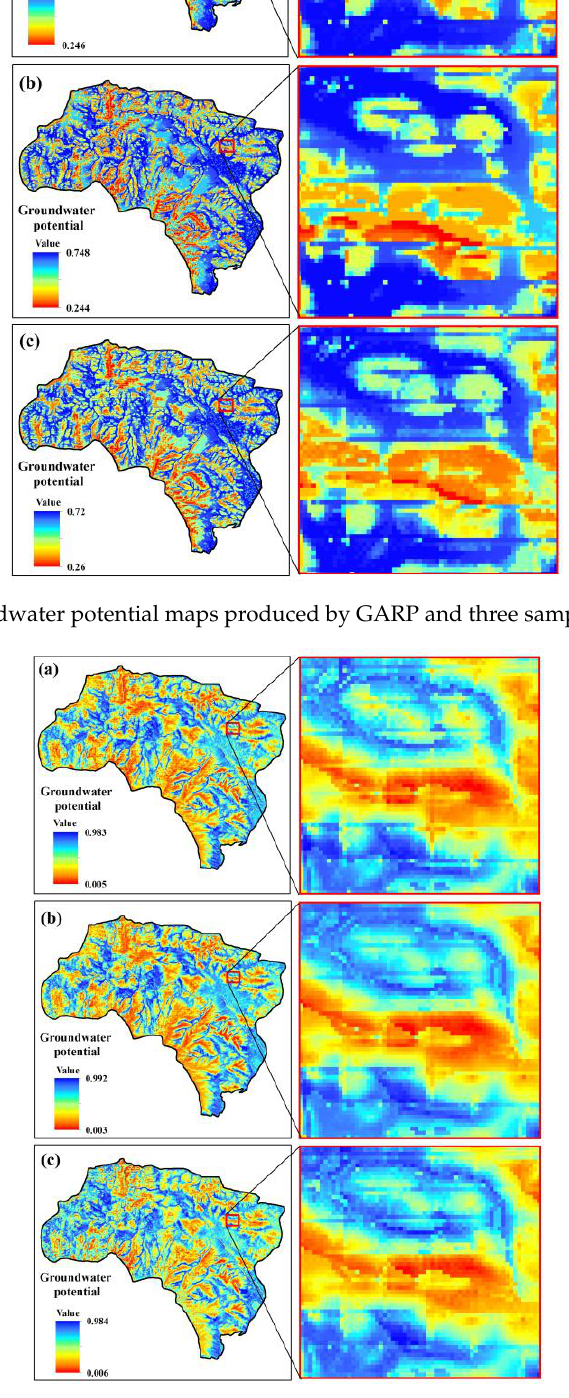
Figure 7. Groundwater potential maps produced by RF and three sample datasets ( a – c ).